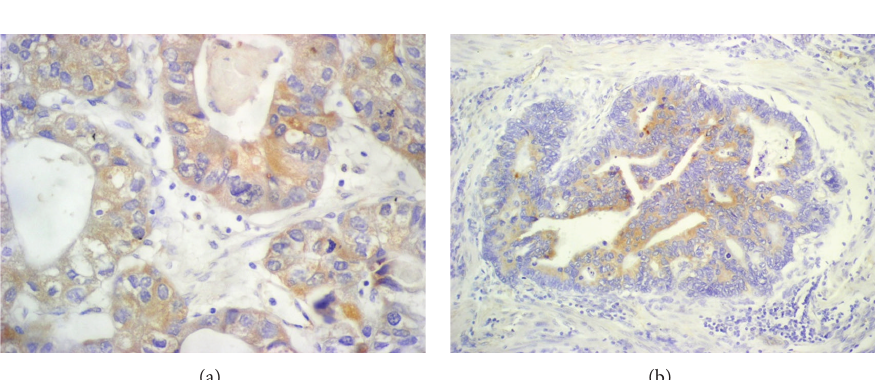
Figure 1: (a) Positive expression of Bcl-2 in cytoplasm of gastric cancer cells (IHC stain, × 20). (b) Positive expression of BID in cytoplasm of gastric cancer cells (IHC stain, ×